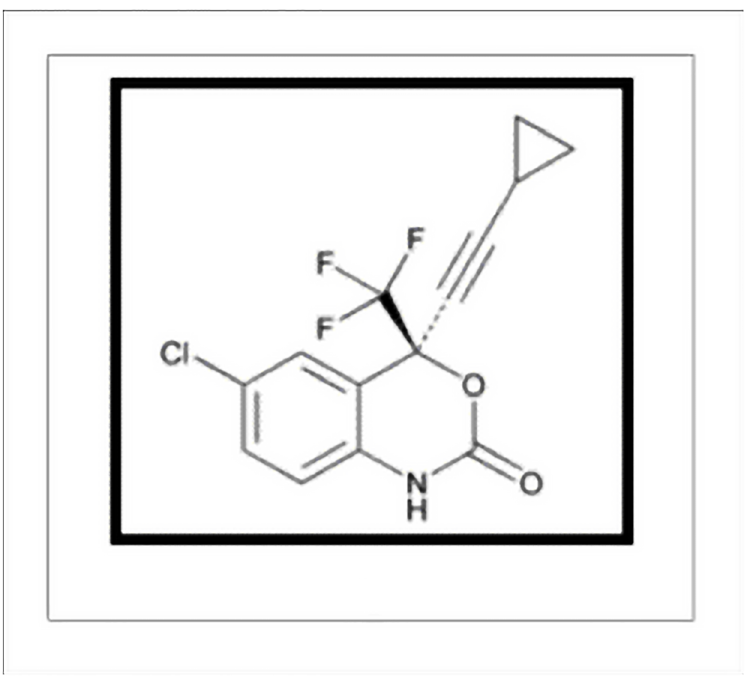
Fig 1. Structure of